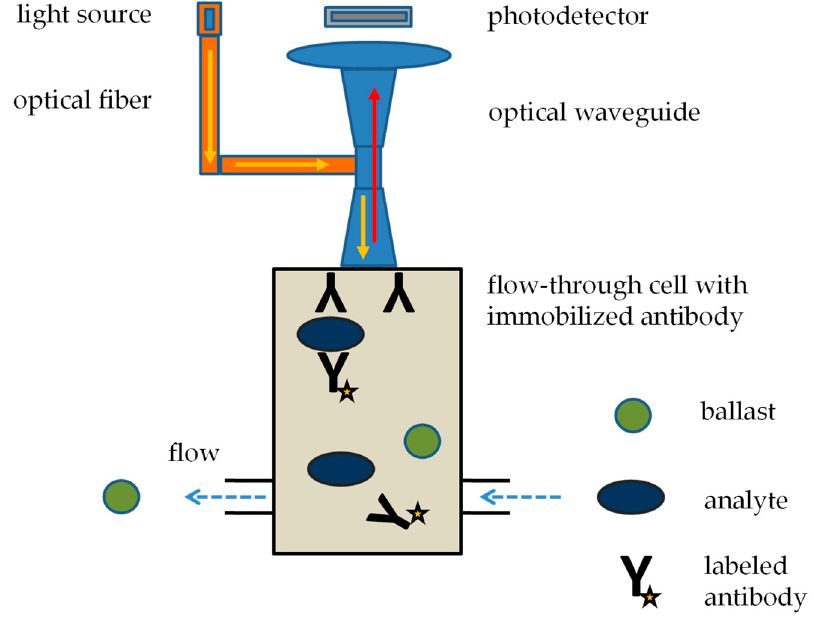
Figure 2. Principle of Raptor analytical device based on a fluorescence immunoassay. Blue arrow: liquid flow, yellow arrow: exciting light, red arrow: emitted light.